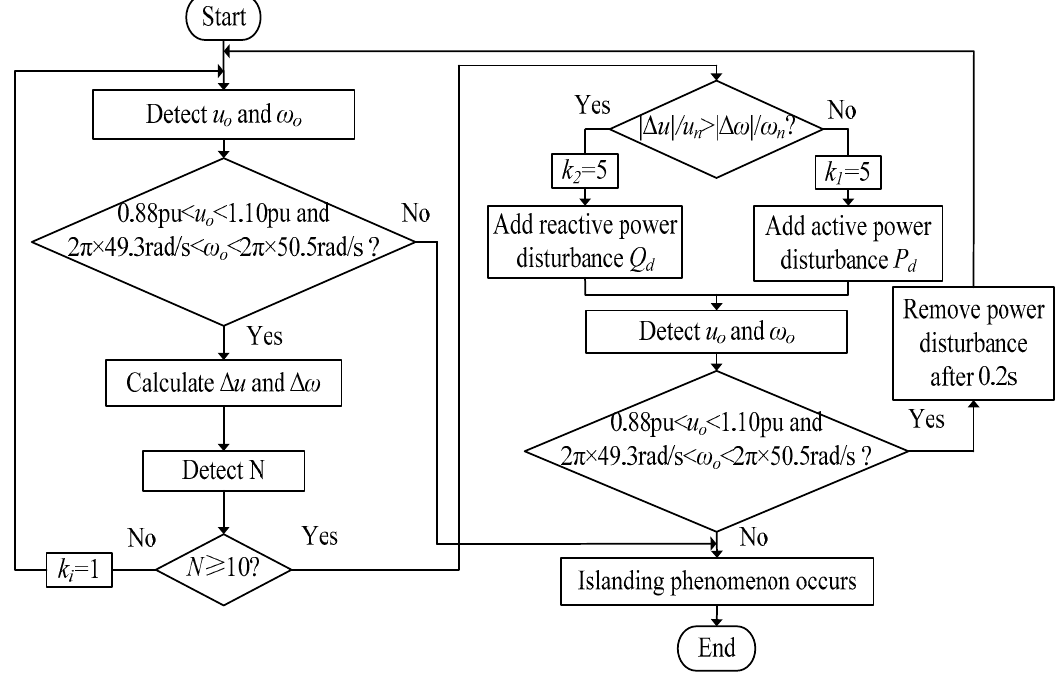
Figure 10. Flowchart of the islanding detection.